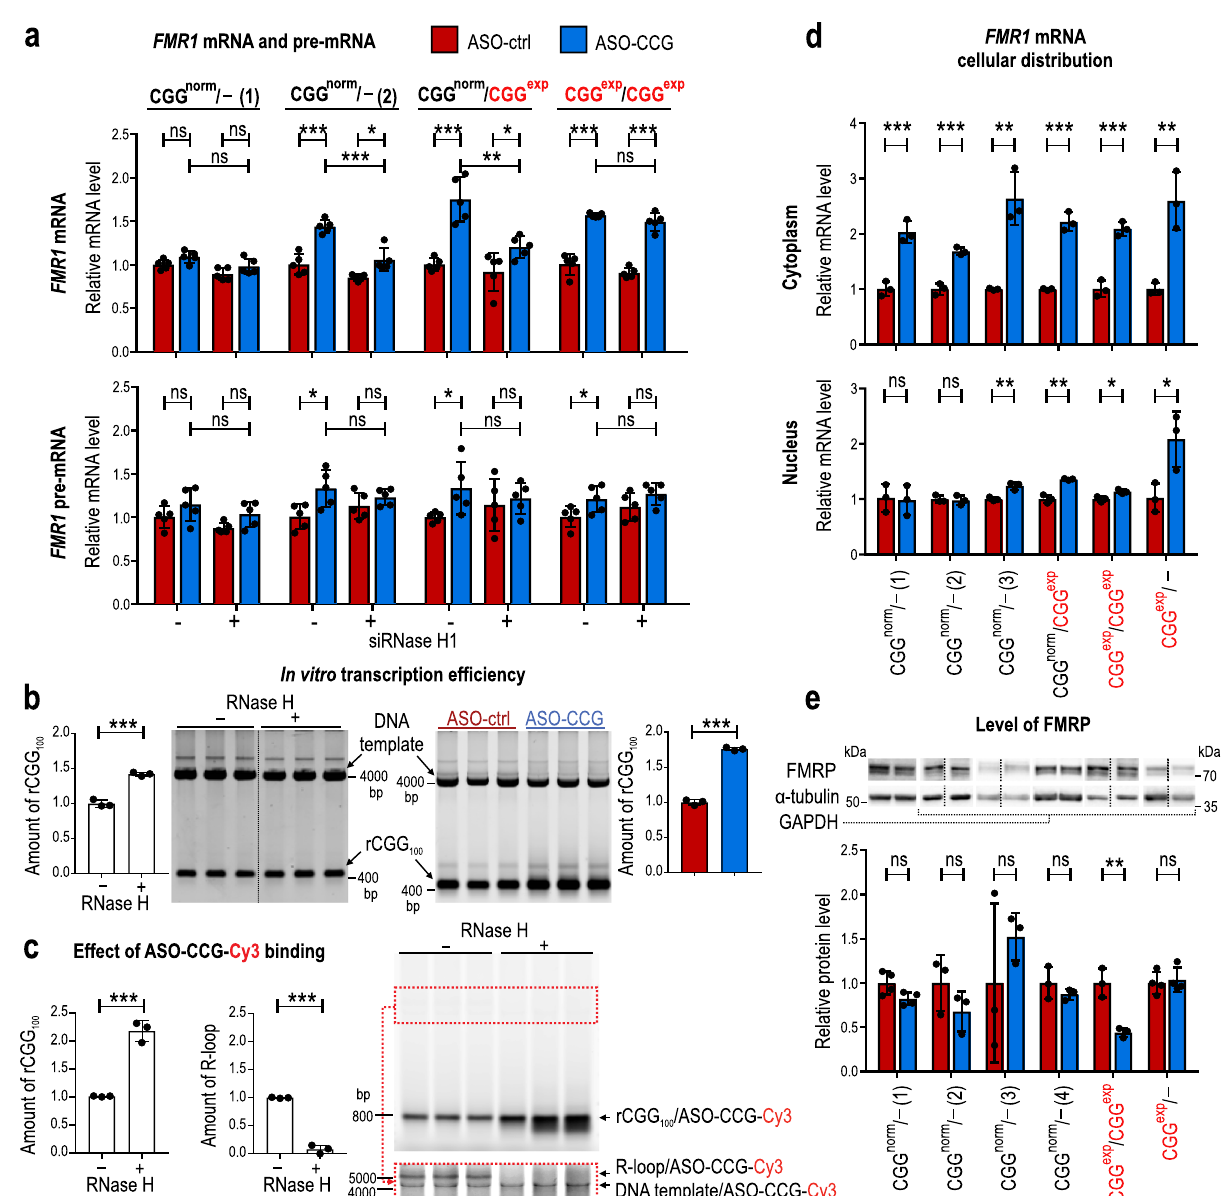
Fig. 3 The effect of ASO – CCG on the FMR1 pre-mRNA, mRNA, and FMRP levels in FXTAS patient-derived fi broblasts. a Analysis of the total FMR1 mRNA and pre-mRNA levels in fi broblasts treated with ASOs. Fibroblasts were transfected with siRNA against RNase H1 or control siRNA and with ASOs (9 or 11 nt, 200 nM). Graphs present RT-qPCR results for N = 5 biologically independent samples. b Increase in the ef fi ciency of in vitro transcription in the presence of ASO – CCG or RNase H. rCGG 100 signal was measured for N = 3 independent samples. c Correlation between R-loop formation and ef fi ciency of transcription of RNA containing CGG 100 . Graphs present quanti fi cation of the fl uorescent signal coming from fl uorescently labeled ASO – CCG-Cy3 bound to either rCGG 100 or R-loop structure for N = 3 independent samples. The area of the gel marked with a red box was exposed to higher laser power strength and the result is presented below the main gel. DNA template was the same as in b , but the observed signal came only from partially single-stranded DNA in the region of CGG/CCG repeats or R-loop bound with ASO – CCG-Cy3. d Cellular distribution of FMR1 mRNA in fi broblasts treated with ASOs (9 nt, 200 nM). Graphs present RT-qPCR results for the cytoplasmic and nuclear fractions for N = 3 biologically independent samples. Results were normalized to GAPDH . e Changes in the steady-state level of FMRP after treatment with ASO – CCG. Fibroblasts were transfected with 200 nM ASOs (9 or 11 nt). The graph presents western blot results for N = 4 biologically independent samples (CGG norm /- (1) and CGG exp /-) and N = 3 (other cell lines). a – e Graphs present means of indicated N with the SDs. a , b , d , e Red bars, ASO-ctrl; blue bars, ASO – CCG. a , d , e The used cell lines contained one allele with a normal CGG repeat length (CGG norm /-; lines (1), 20 CGG repeats; (2), 31 CGG repeats; (3) and (4)); one allele with a normal CGG repeat length and one allele with CGG exp (CGG norm /CGG exp ); two alleles with CGG exp (CGG exp / CGG exp ) and one allele with CGG exp (CGG exp /-). b , c , d Gels were cropped. a – e Two-sided, unpaired Student ’ s t test; * P < 0.05; ** P < 0.01; *** P < 0.001; ns, non-signi fi cant. Source data are provided as a Source Data fi